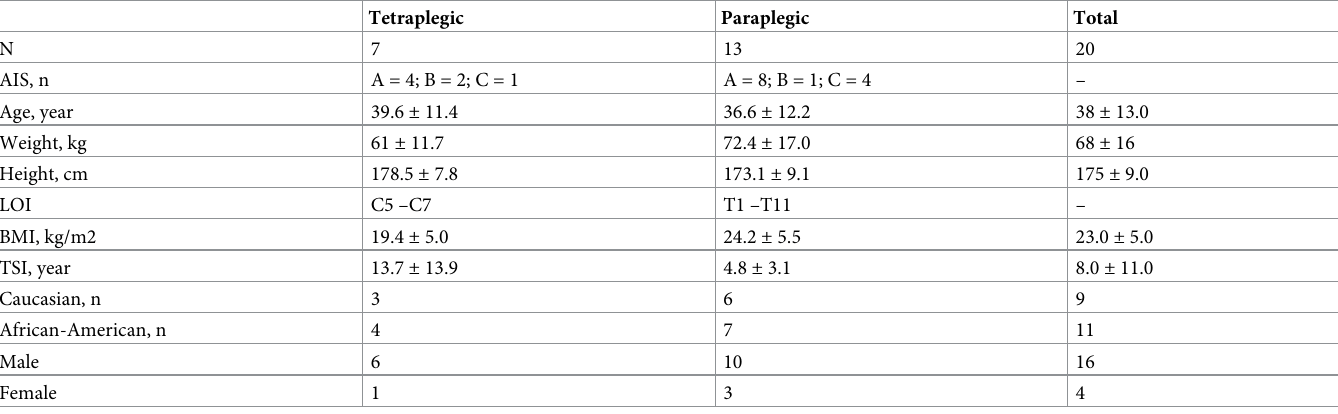
Table 1. Participant demographics.